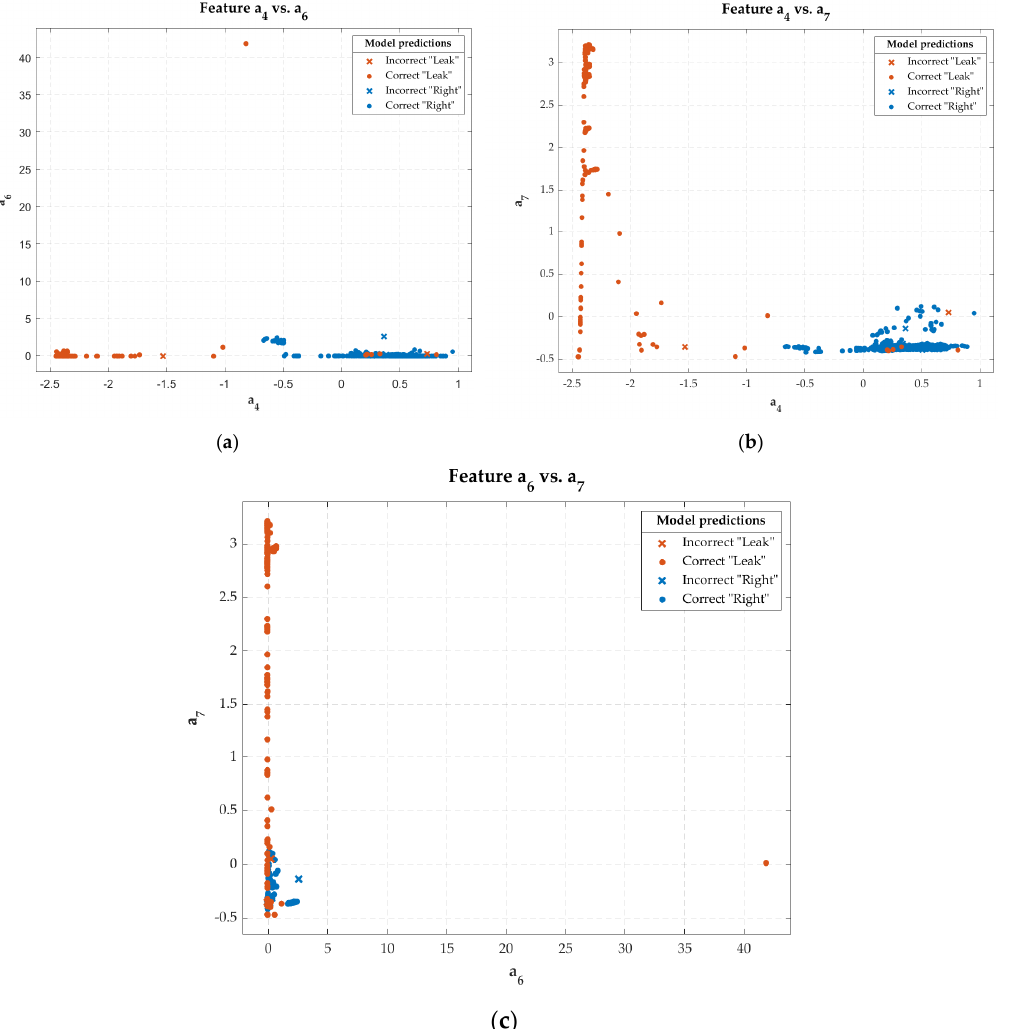
Figure 8. Scatter plots with the classification results of the predictive medium tree model with the input features a 4 , a 6 , and a 7 : scatter plot of feature a 4 vs. a 6 ( a ); scatter plot of feature a 4 vs. a 7 ( b ); scatter plot of feature a 6 vs. a 7 ( c ) .